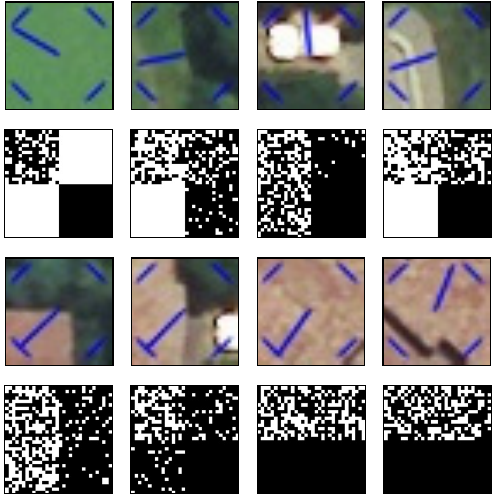
Figure 1. Original input orthophoto